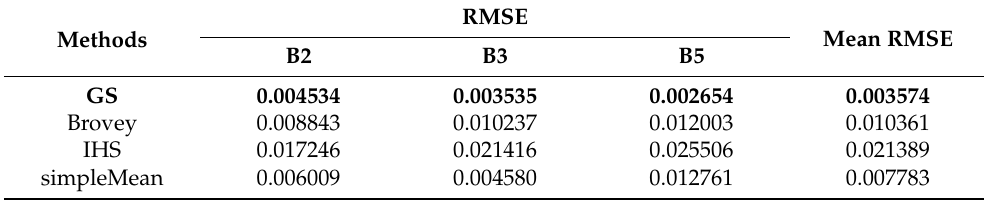
Table 2. Comparison of the accuracy of different pansharpening methods (the best results are bolded).